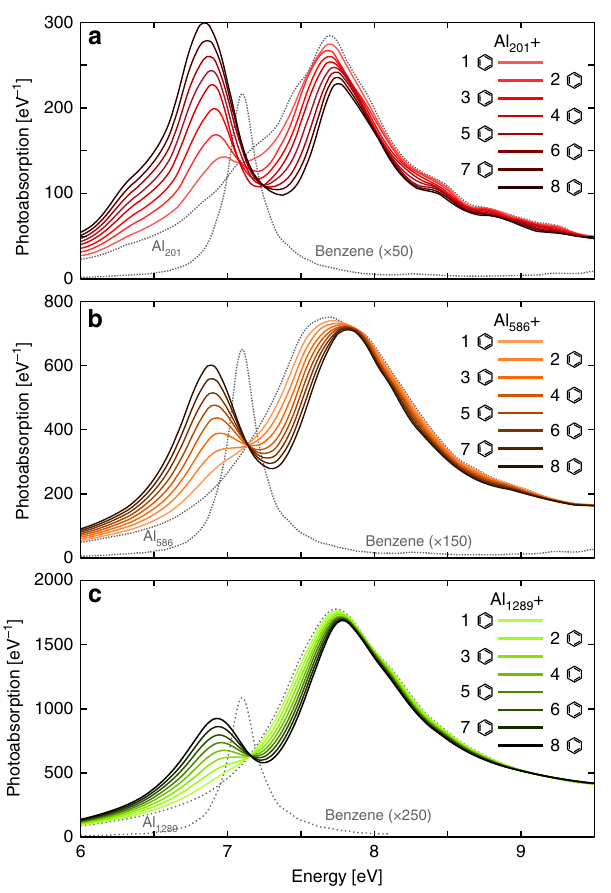
Fig. 2 Strong coupling of plasmons in Al nanoparticles and excitations in benzene molecules. The calculated photoabsorption spectra of nanoparticle-molecule systems composed of ( a ) Al 201 , ( b ) Al 586 , and ( c ) Al 1289 nanoparticles coupled with N benzene molecules at 3 Å separation (solid lines) show clearly separated lower and upper polaritons, the splitting of which increases with N . Spectra of the bare Al particles and benzene molecule are shown for reference (dotted lines)